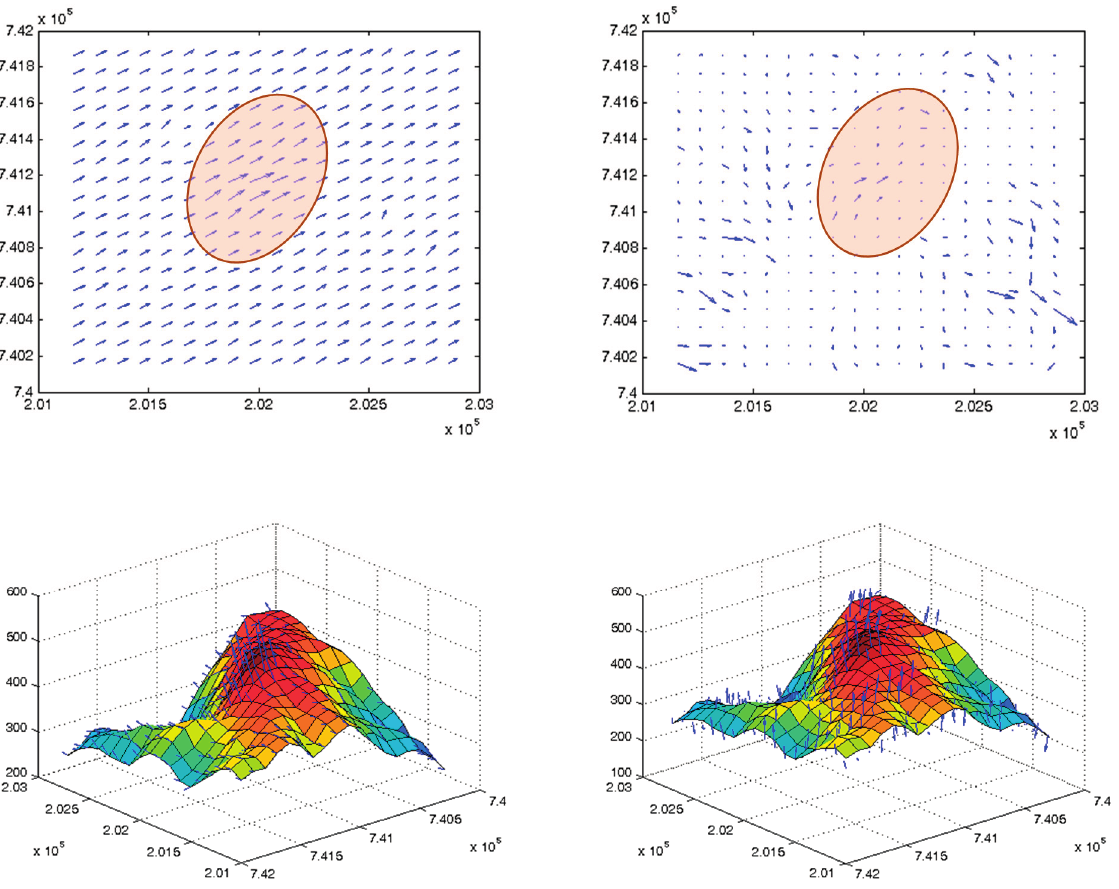
Figure 14. Landslide detection: results received by using the proposed mechanism of hierarchical registration and matching ( left ), and results received via the straightforward coordinate-based comparison ( right